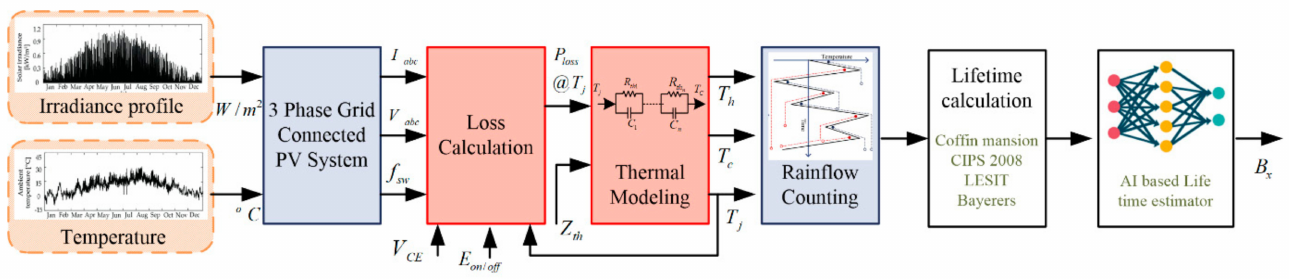
Figure 13. Reliability analysis of a power electronics